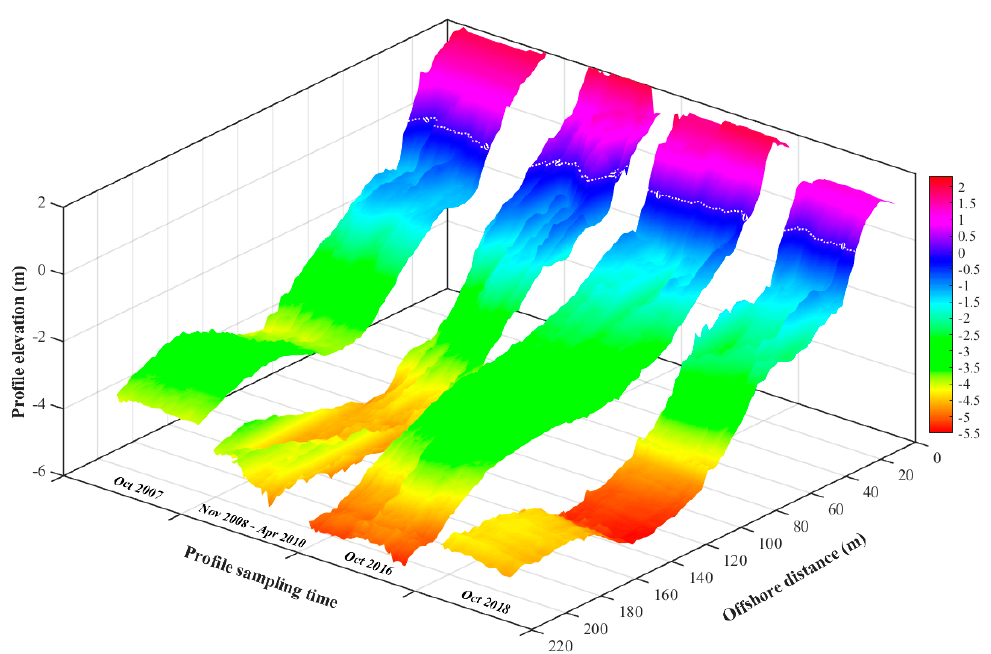
Figure 2. Coastal morphodynamics constructed from cross-shore profile measurements for all field experiments in October 2007, November 2008–April 2010, October 2016 and October 2018 at Kamchia-Shkorpilovtsi beach; white dashed line—contour of the mean sea level.